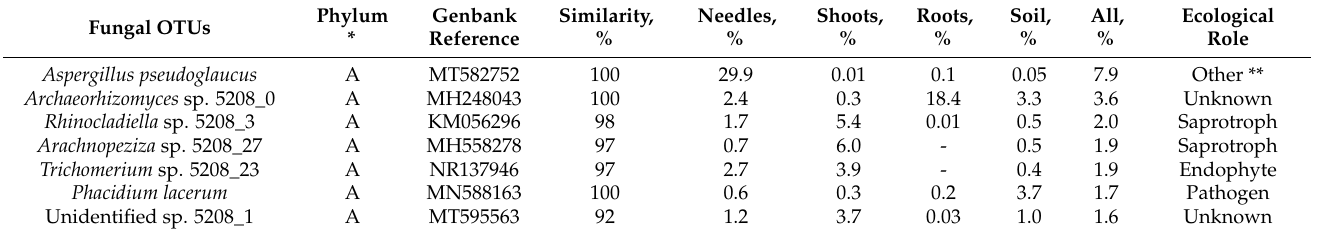
Table 3. Occurrence and relative abundance of the 25 most common fungi (shown as a proportion of all high-quality fungal sequences) found in different substrates. The data from different sites are